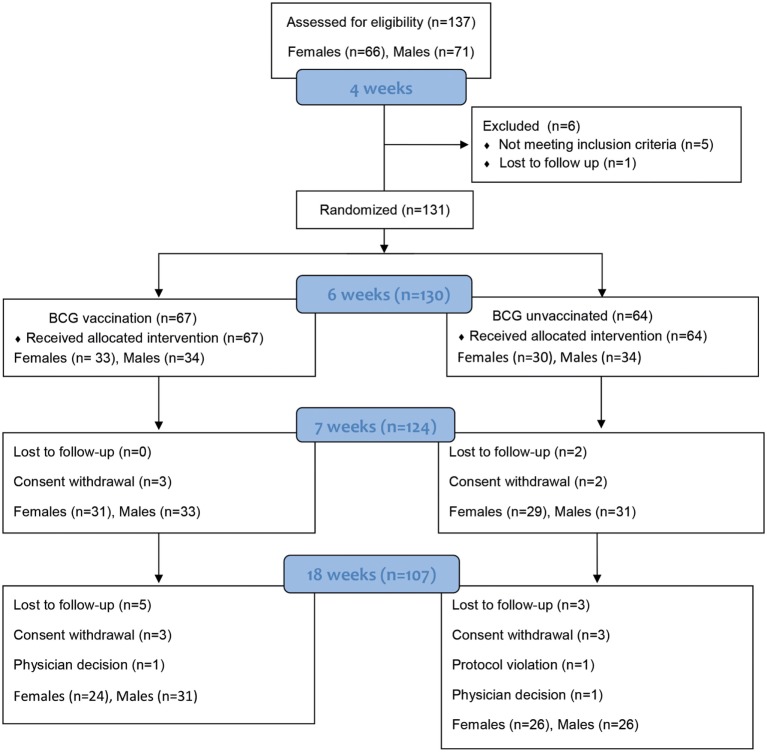
Participant numbers and drop outs. Numbers of study infants throughout the study from recruitment at birth, to enrollment and randomization, and follow-up until 18 weeks of age. Infants were bled at three time points—Visit 1 (V1) at 6 weeks of age (baseline), visit 2 (V2) at 7 weeks (+1 week) and visit 3 (V3) at 18 weeks of age (+12 weeks).